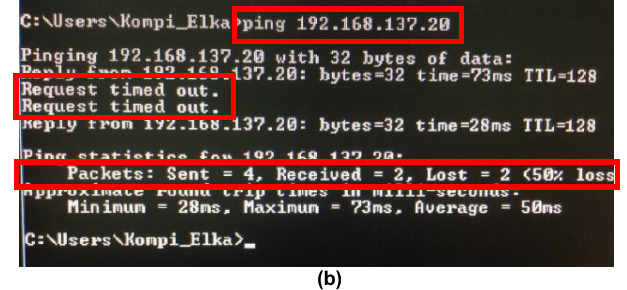
Figure 18. A photograph of: (a) the PC monitor connected to the Client ( PC Host ); (b) command prompt the error is existed